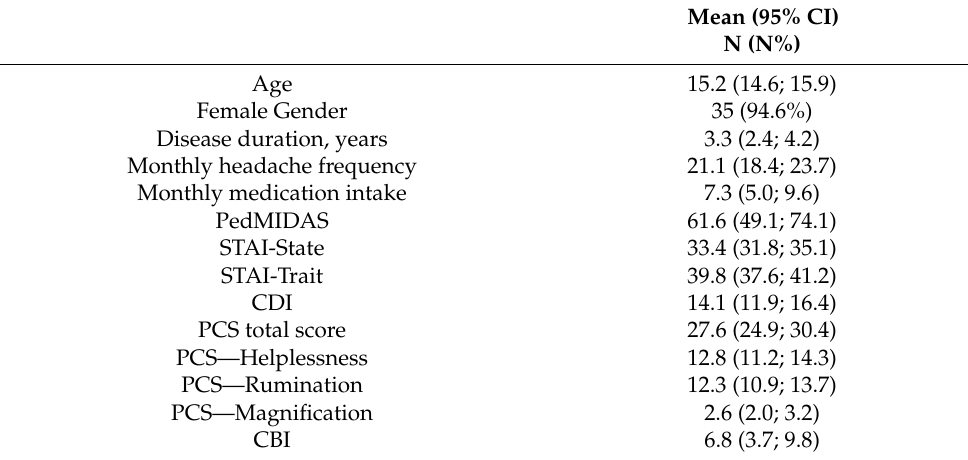
Table 1. Baseline description of enrolled